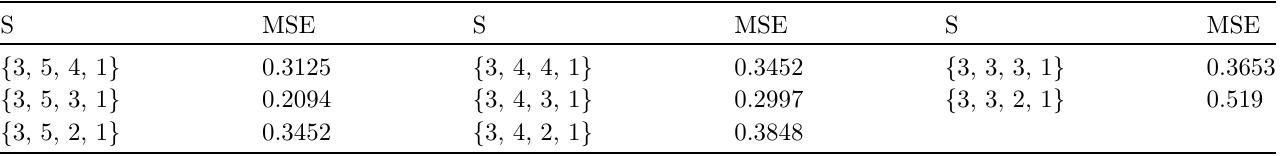
Table 6. ANN Algorithm: RPROP+.